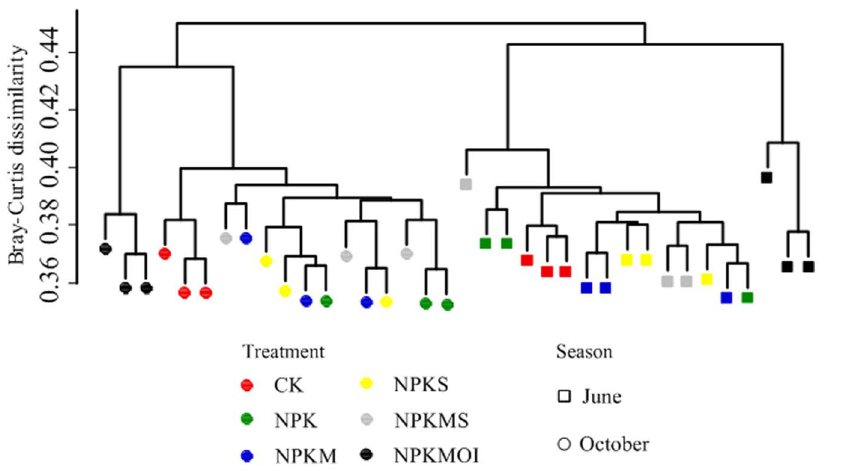
Figure 1. Hierarchical cluster dendrogram of bacterial communities. Pairwise Bray-Curtis dissimilarity of samples collected from six fertilizer treatments in June (square) and October (circle). OTU counts were rarefied to 3,000 counts per sample, and only OTUs $ 20 counts summed across all samples were included in the analysis with the Hellinger-transformation. Symbols of fertilizer regimes were as described in Table 1.